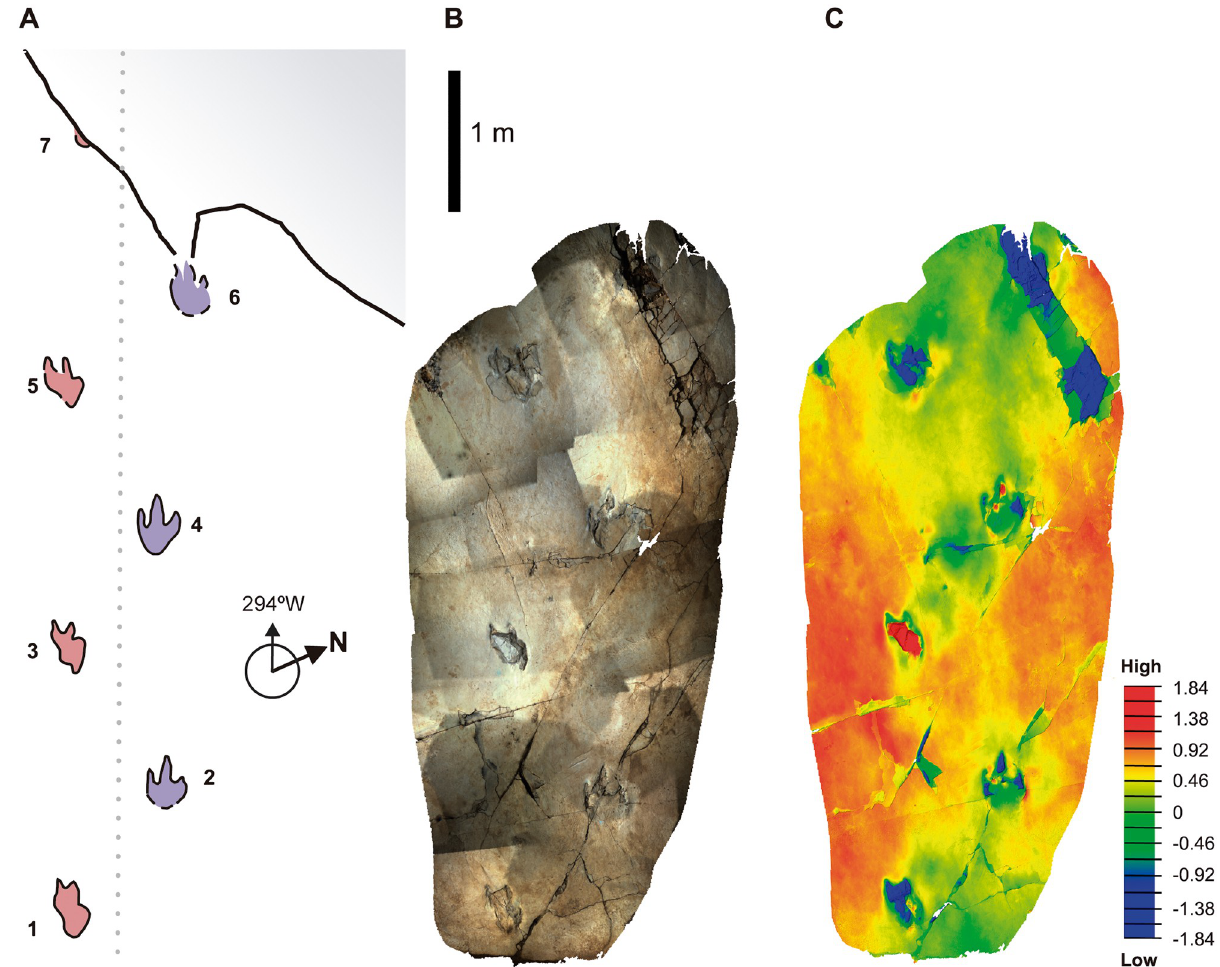
Fig 3. Magenta LH-Mg-10-16 trackway. (A) Cartography done in the field, (B) Scanned surface of the trackway, mounted from a set of color photos. (C) Color ramp, showing the depths in the legend (in cm). Scale, 1 meter. The cartography is reprinted from Las Hoyas a Cretaceous wetland, Gibert JM et al. [22] under a CC BY license, with permission from Dr. Friedrich Pfeil Verlag, original copyright